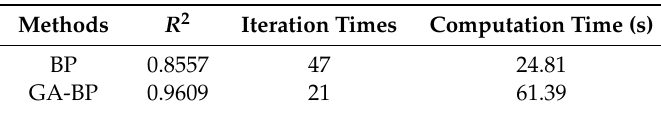
Table 5. Comparison of the BP and GA-BP